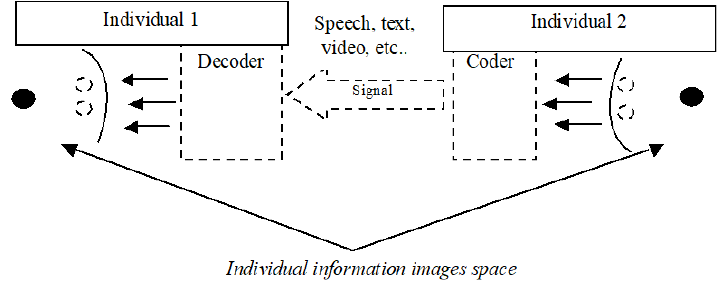
Figure 2. Schematic diagram of the interaction between the communicative fields of individuals. Virtual Particle Theory and Its Comparison with TII